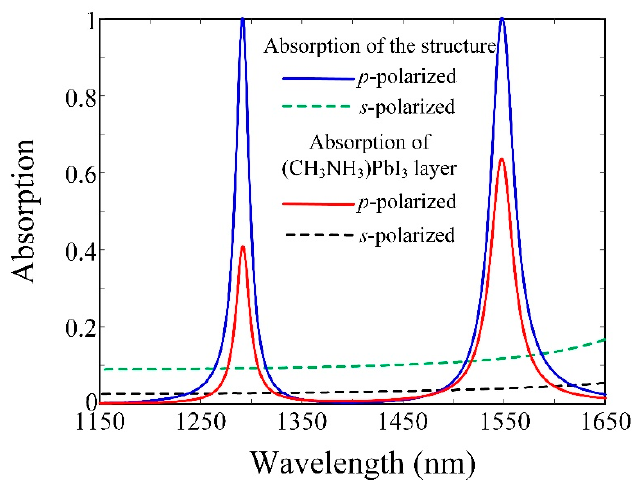
Figure 3. Absorption of the proposed structure and (CH 3 NH 3 )PbI 3 layer under illumination of p-polarized and s-polarized normal incident light, respectively, where P = 800 nm, w = 550 nm, h = 15 nm.